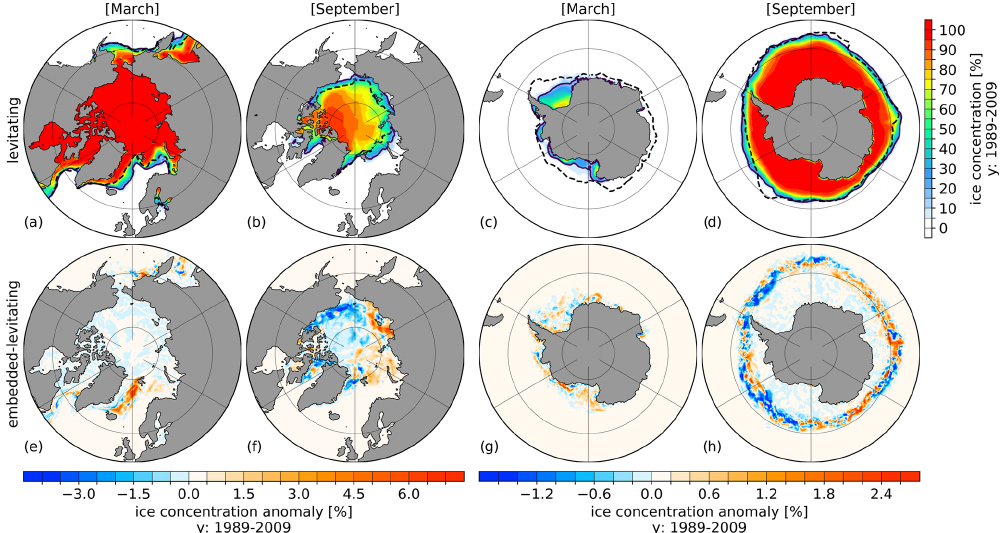
Figure 6. Levitating (a–d) Northern Hemisphere and Southern Hemisphere March (a, c) and September (b, d) sea ice concentration averaged for the period 1989–2009. Solid and dashed lines indicate the simulated and observed (Cavalieri et al., 1996) contour of the 15% sea ice extent, respectively. The lower row shows the corresponding sea ice concentration anomalies between embedded and levitating sea ice (embedded minus levitating) averaged over the same